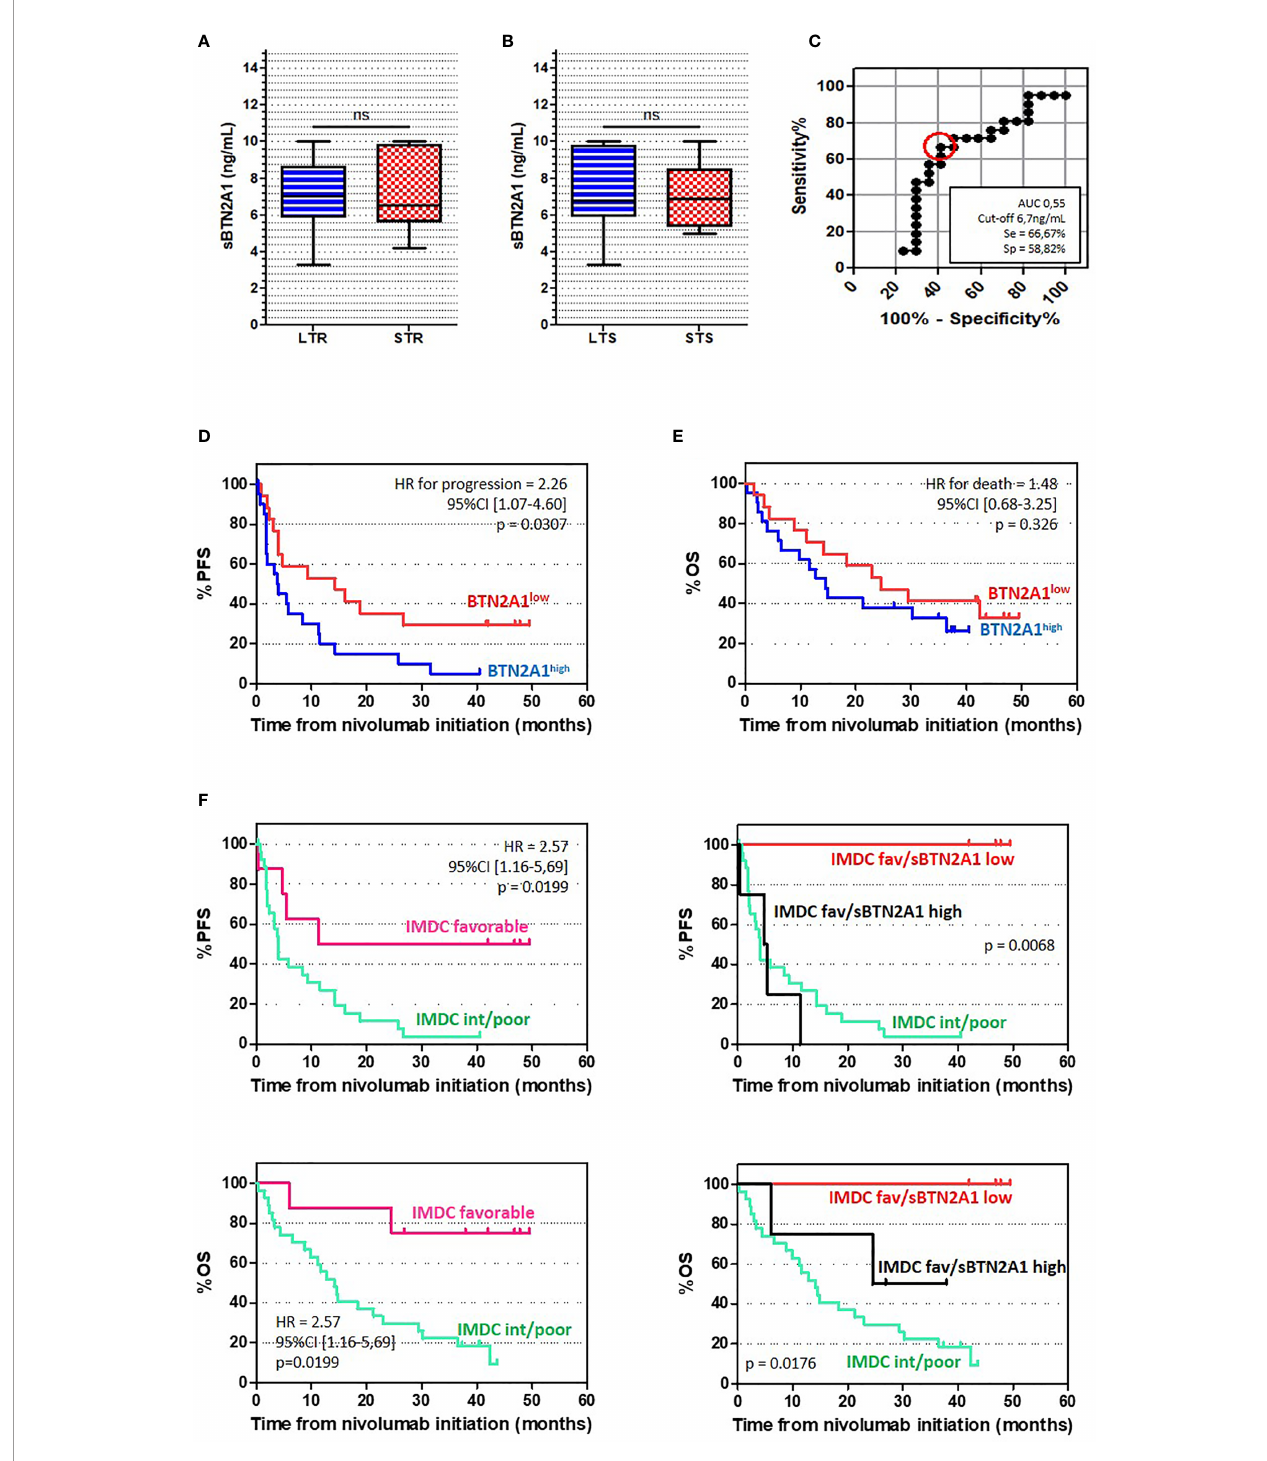
FIGURE 1 | sBTN2A1 seemed to be an independent prognostic factor for PFS in patients with mRCC (A, B) sBTN2A1 expression according to the time of response (A) and the time of overall survival (B) , assessed par enzyme linked immunosorbent assay. Paired-t test was used to compare differences between the groups. LTR, Long term responders; patients with PFS > median; STR, short term responders; patients with PFS < median; LTS, Long term survival; patients with OS > median; STS, Short term survival; patients with OS < median. (C) Receiver operating characteristics (ROC) curve analysis of plasma level for sBTN2A1. ROC curve was plotted for sensitivity and speci fi city of time of response. (D, E) Kaplan Meier analysis of PFS (D) and OS (E) in patients with high and low plasma levels of BTN2A1. (F) Kaplan Meier analysis of PFS (top) and OS (bottom) according to the IMDC prognosis subgroup and sBTN2A1